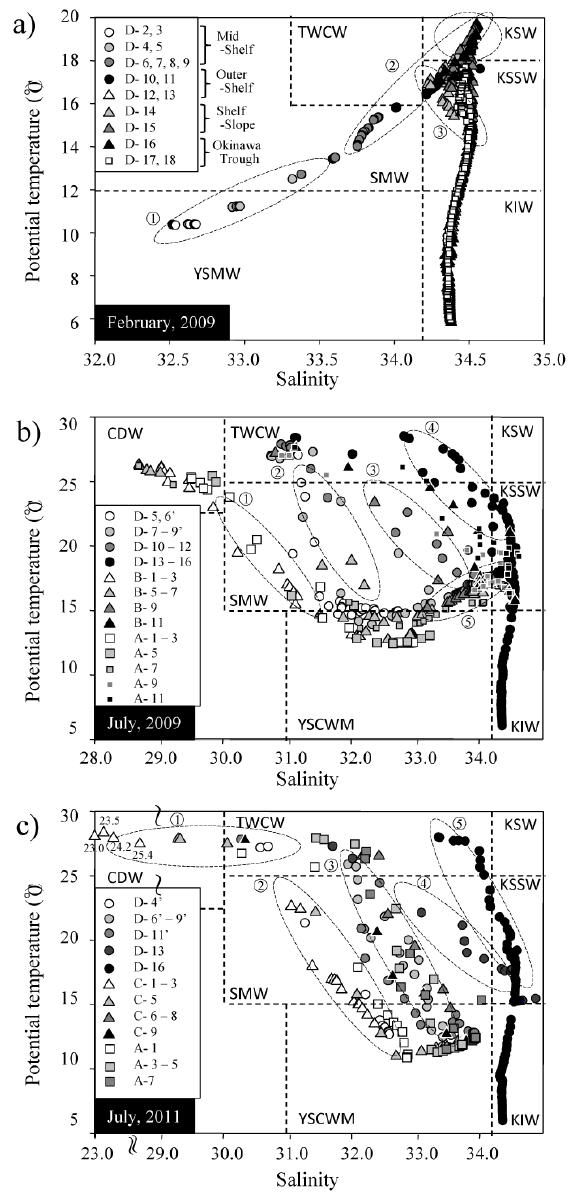
Fig. 6. Plot of salinity–temperature data collected from the surface to the bottom at each station in (a) February 2009, (b) July 2009, and (c) July 2011. The typical salinity–temperature ranges of each water mass – Kuroshio Surface Water (KSW), Kuroshio Subsur- face Water (KSSW), Kuroshio Intermediate Water (KIW), Taiwan Warm Current Water (TWCW), Changjiang Diluted Water (CDW), Yellow Sea Cold Water Mass (YSCWM), Yellow Sea Mixed Wa- ter (YSMW) and shelf mixed water (SMW) – are from Zhu et al. (2004), Zhang et al. (2007a, b, 2008), and Chen (2008). The oval circles of the dotted line with numbers show the potential mixing of different water masses, which can be partly enhanced by turbulence and diffusive convection. Low-salinity waters that were out of range are additionally depicted with salinity values in (c)